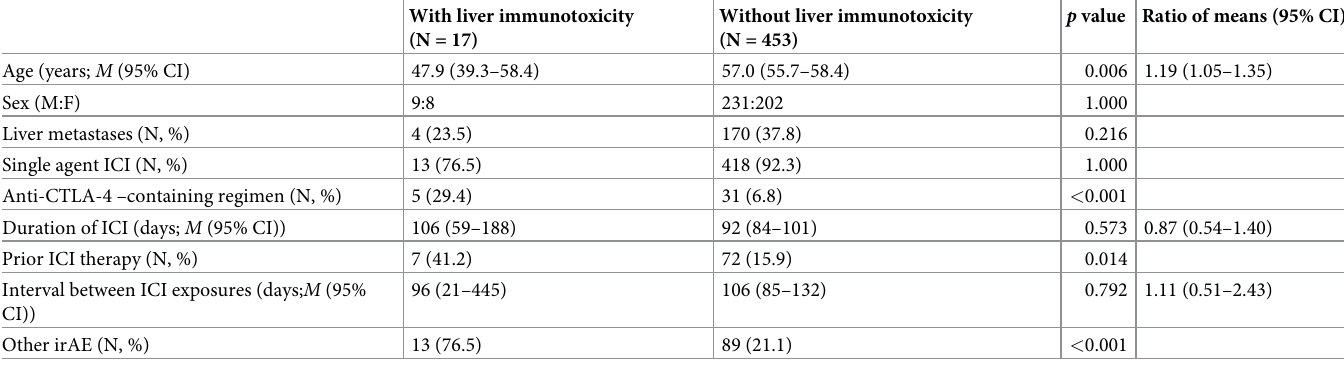
Table 2. Comparison between patients diagnosed with liver immunotoxicity and patients exposed to checkpoint inhibitor (ICI) therapy who did not develop immunotoxicity. With liver immunotoxicity (N =